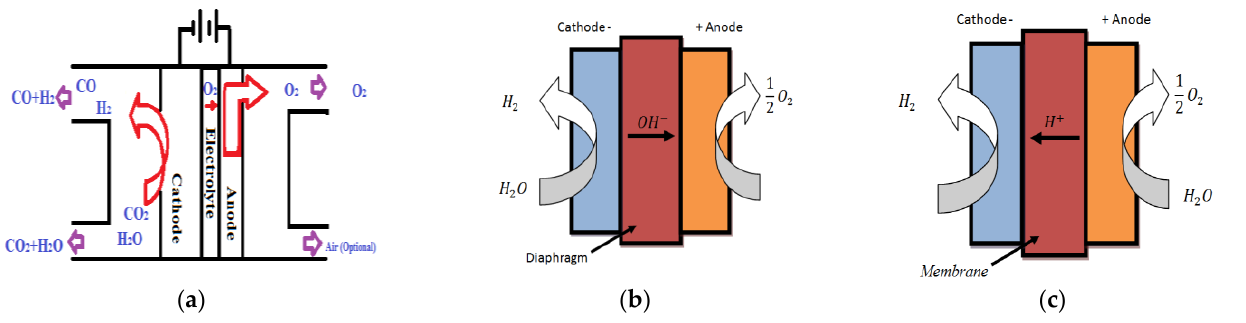
Figure 1. ( a ) Solid oxide electrolysis (SOEC), ( b ) alkaline water electrolysis, and ( c ) PEM water elec- trolysis.